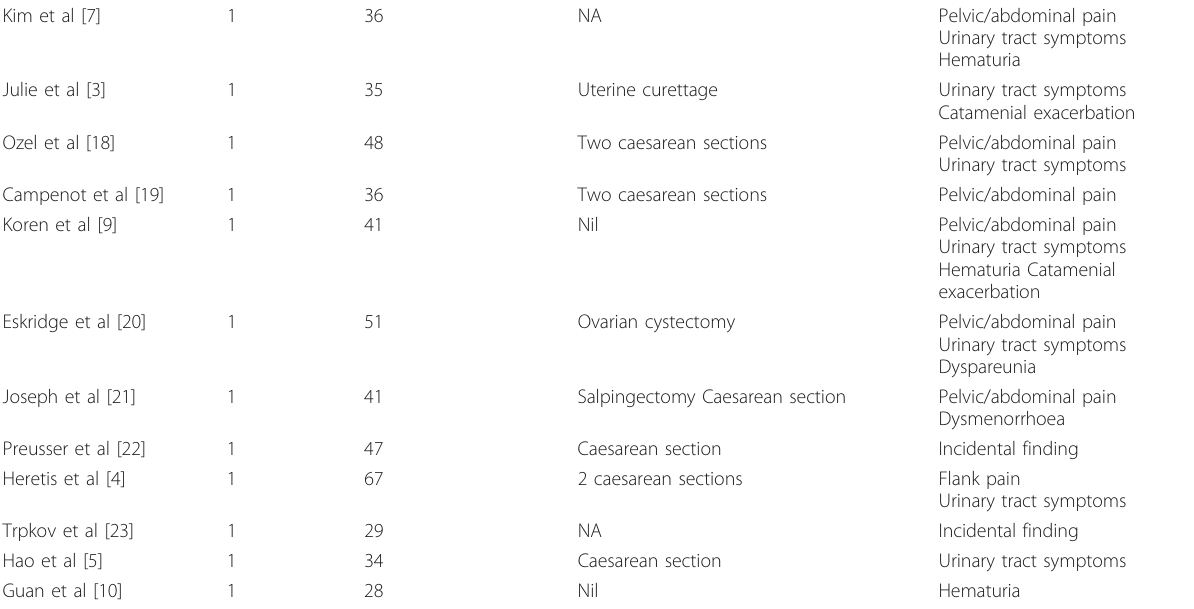
Table 2 Clinical presentation of bladder lesions with presence of endocervicosis